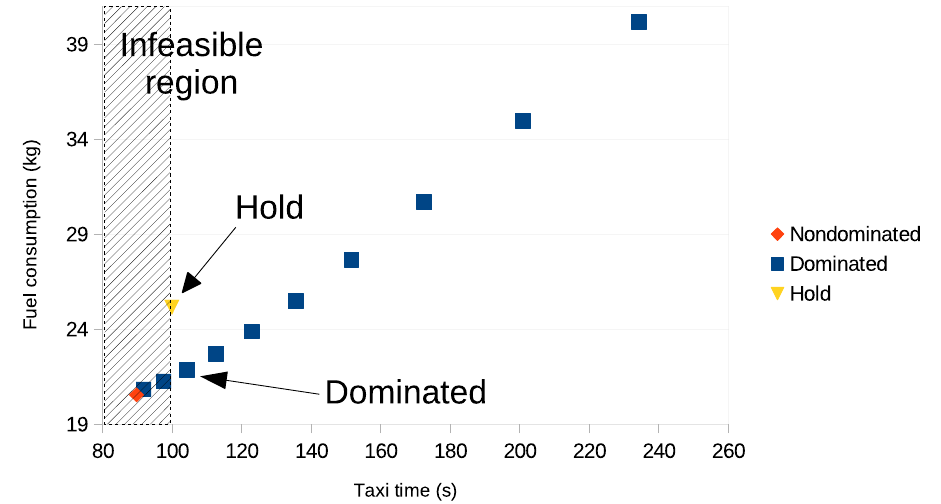
Figure 6. For resolving the infeasible nondominated speed profile, holding can be applied (at additional cost) or another feasible speed profile with the least cost from the dominated speed profiles can be